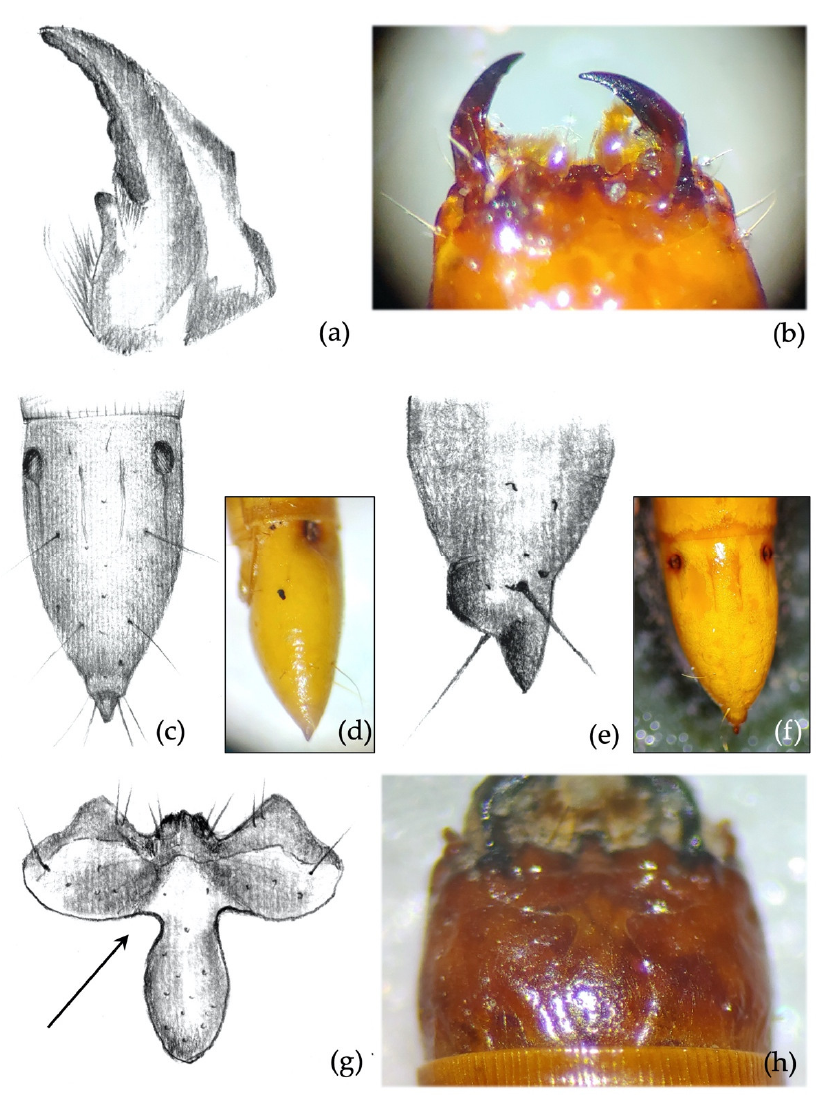
Figure 6. Agriotes litigiosus (Rossi 1792). Discriminating characters: ( a ) details of the right mandible; ( b ) view of the mandibles; ( c ) 9th abdominal segment dorsal view; ( d ) 9th abdominal segment side view; ( e ) 9th abdominal segment side view; ( f ) 9th abdominal segment dorsal view; ( g ) details of the frontoclypeus; ( h ) view of the frontoclypeus on the head.